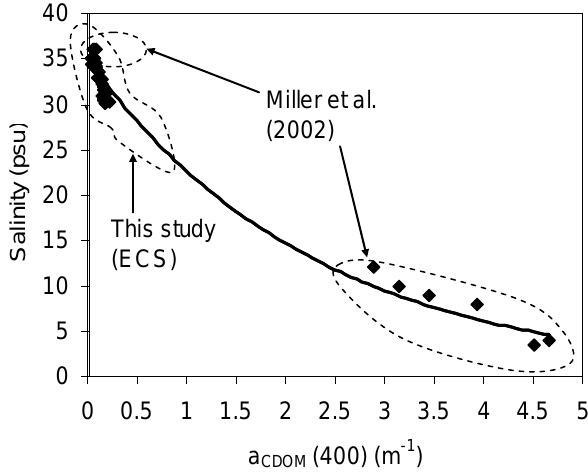
Fig. 5. Relationship between the salinity and a CDOM (400) (m − 1 ) measured in a diverse range of waters from the ECS and other regions (N=37).